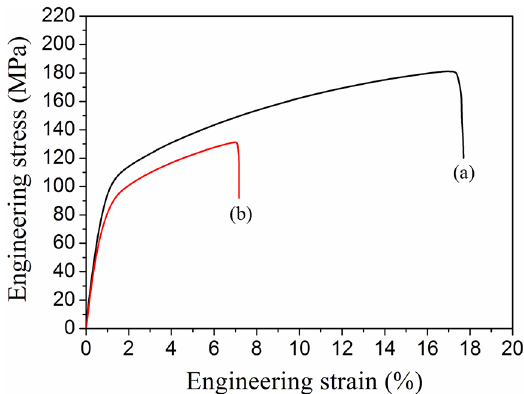
Figure 4. The typical tensile engineering stress-strain curves of the specimens cut from (a) the first copper sample and (b) the second copper